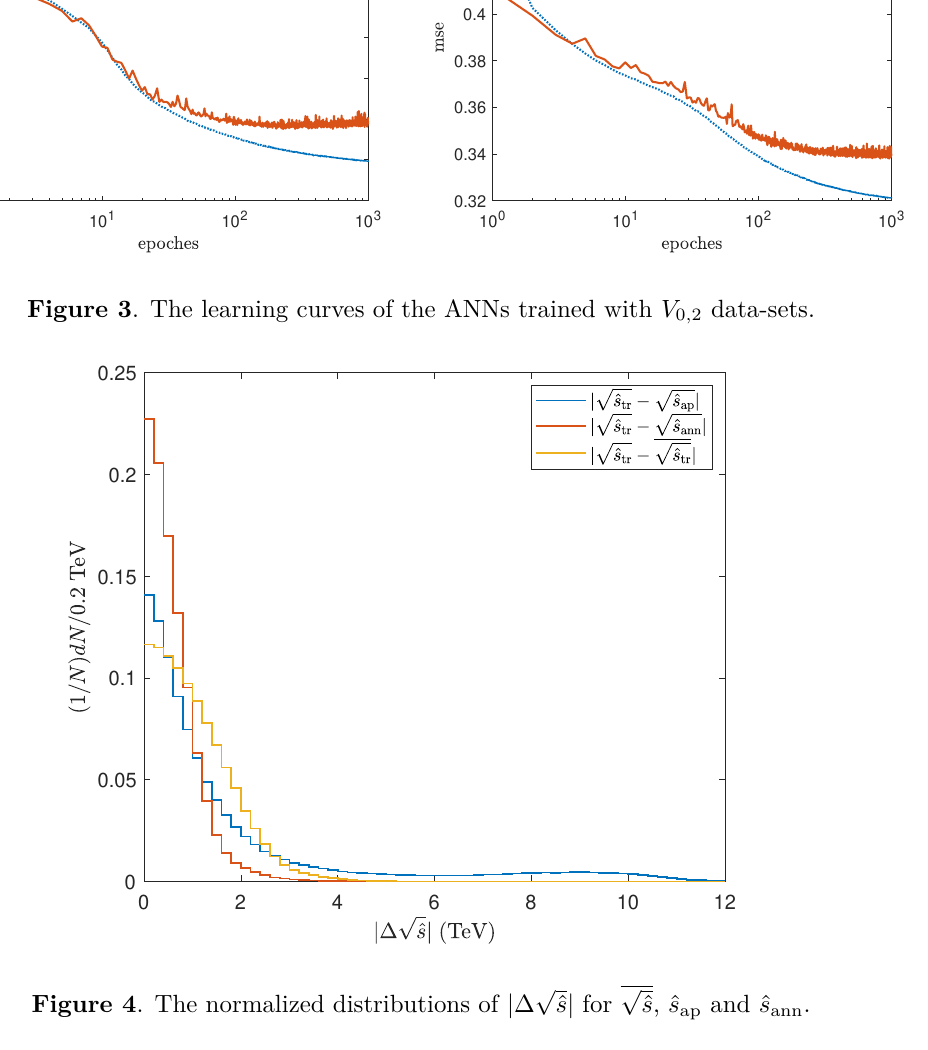
Figure 4 . The normalized distributions of | ∆